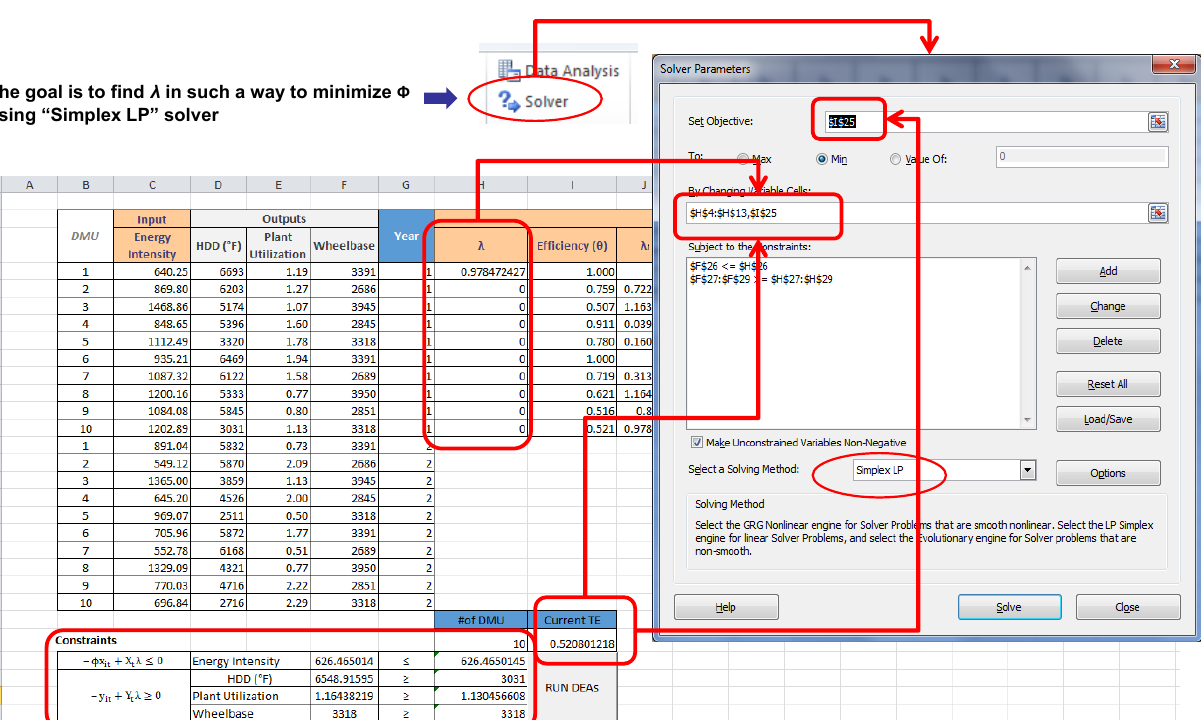
Figure 8. DEA model implementation using MS-Excel Solver with “Simplex LP”.